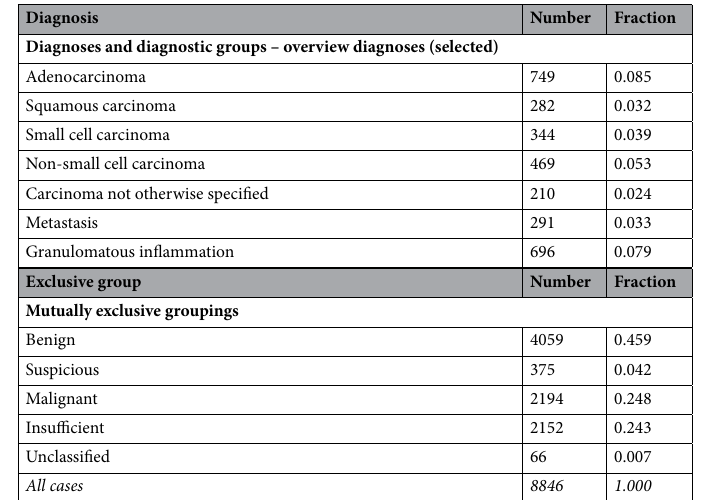
Table 1. Lymph node cohort by diagnosis and mutually exclusive grouping. Note: All cases in itlaics was put in italics to emphasize that it is a summation of all the above mentioned 5 mutually exlusive categories.